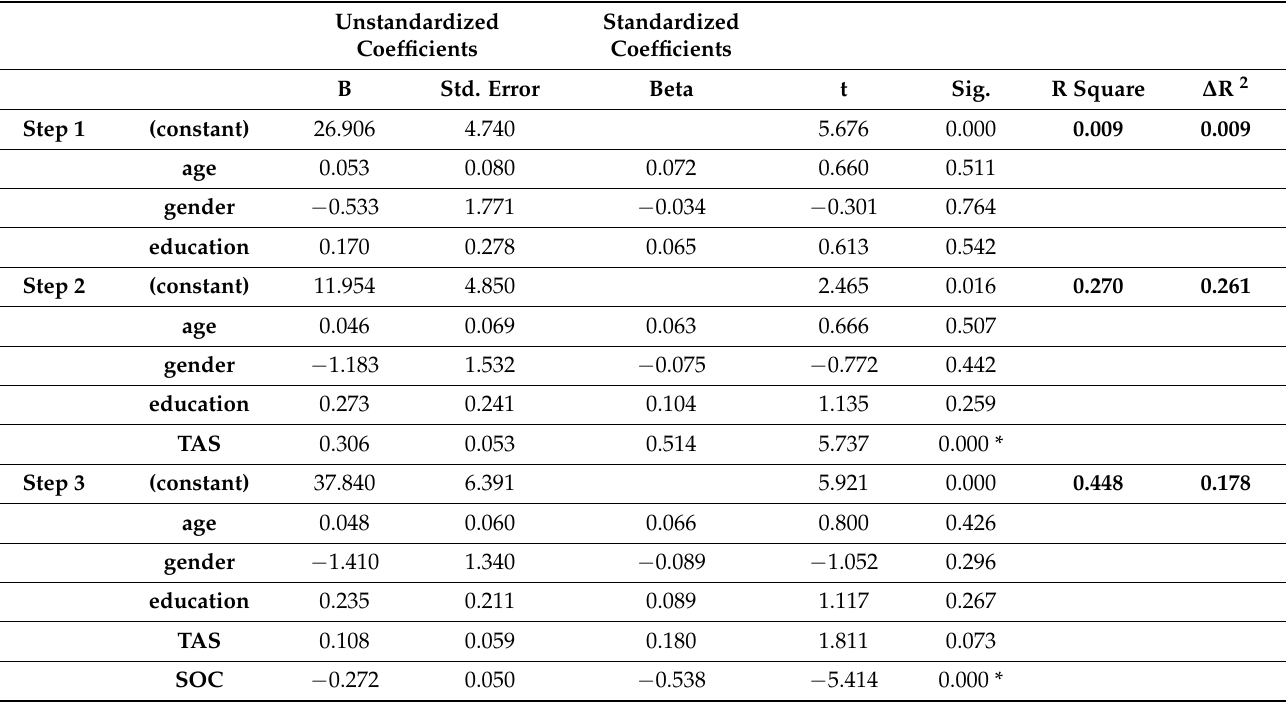
Table 4. Summary of hierarchical regression analysis for variables predicting aggression (BAQ scores).